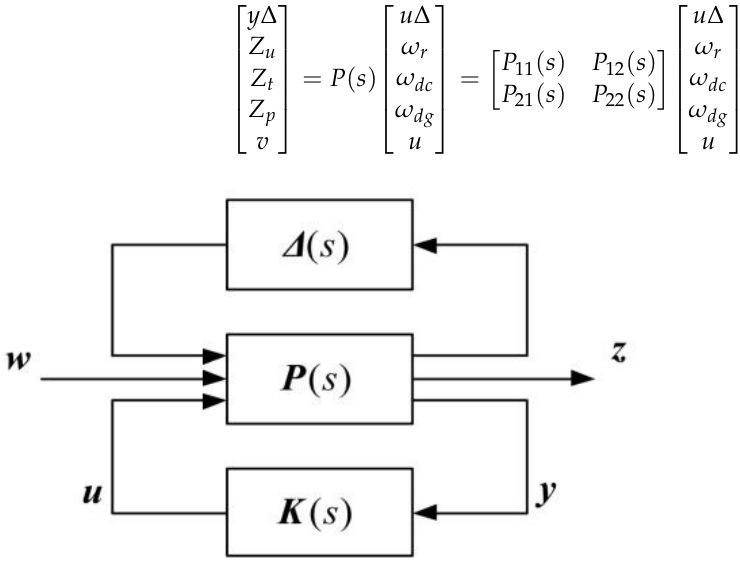
Figure 20. H ∞ Control Standard Problem.